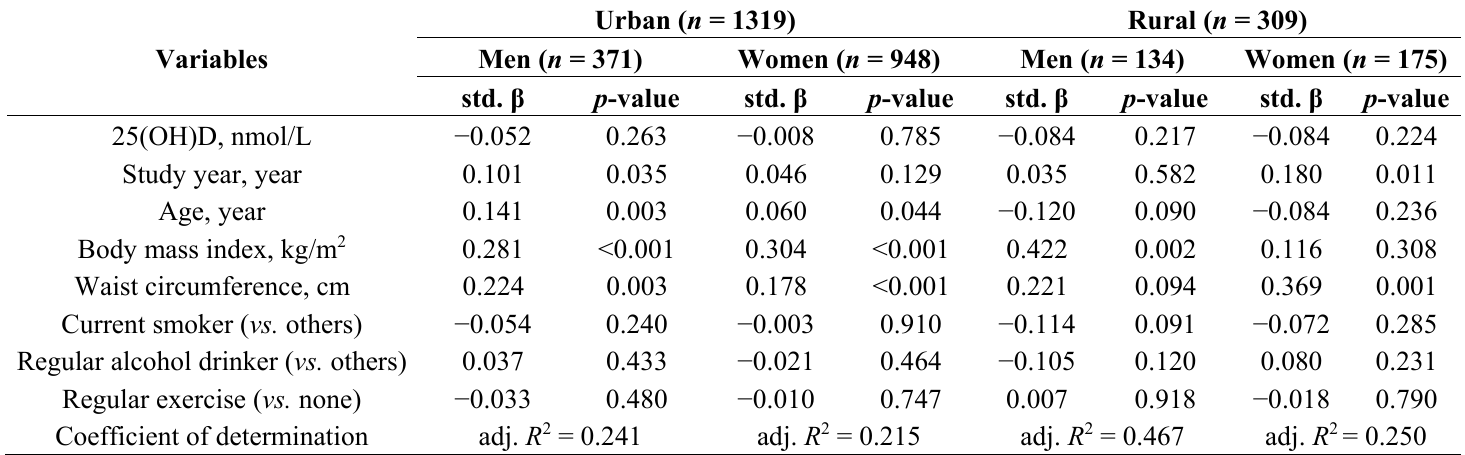
Table 6. Association between log-transformed serum 25(OH)D and log-transformed HOMA-IR in men and women according to residential area.